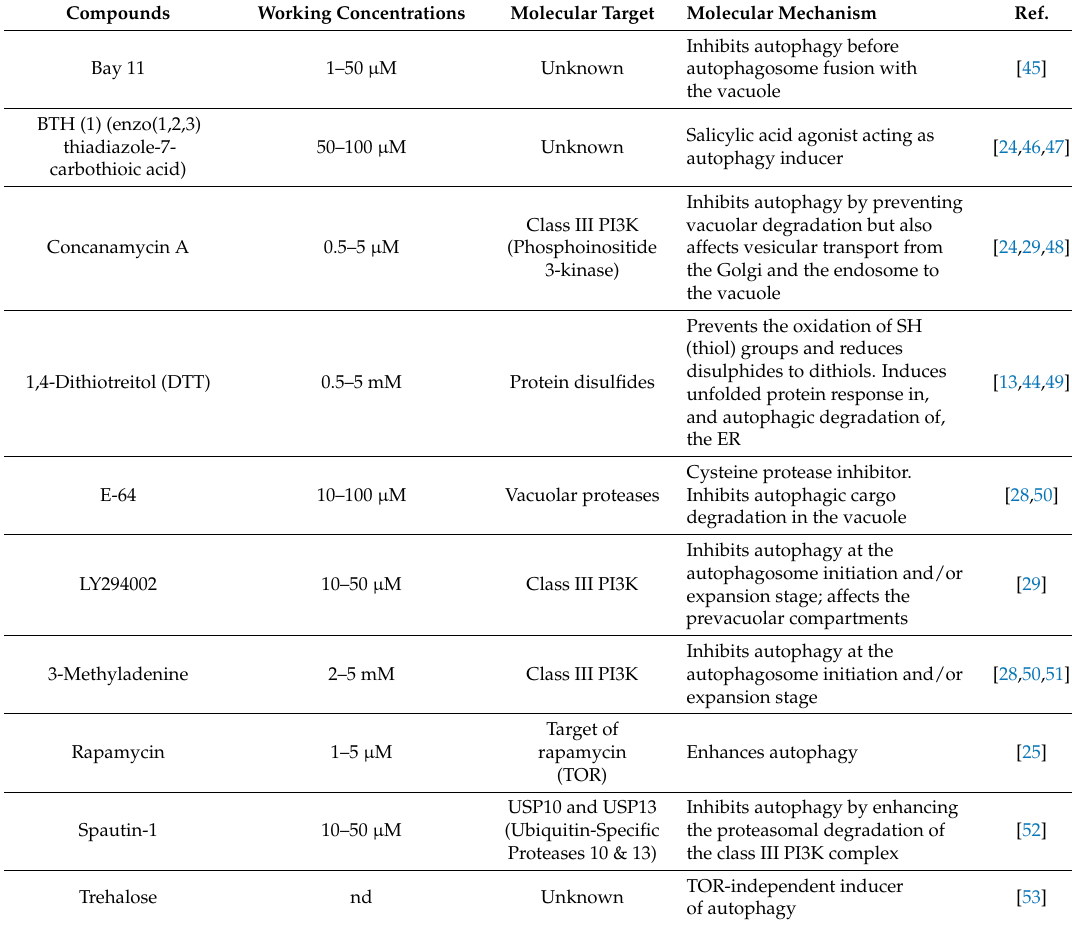
Table 2. Validated pharmacological compounds modulating autophagy in